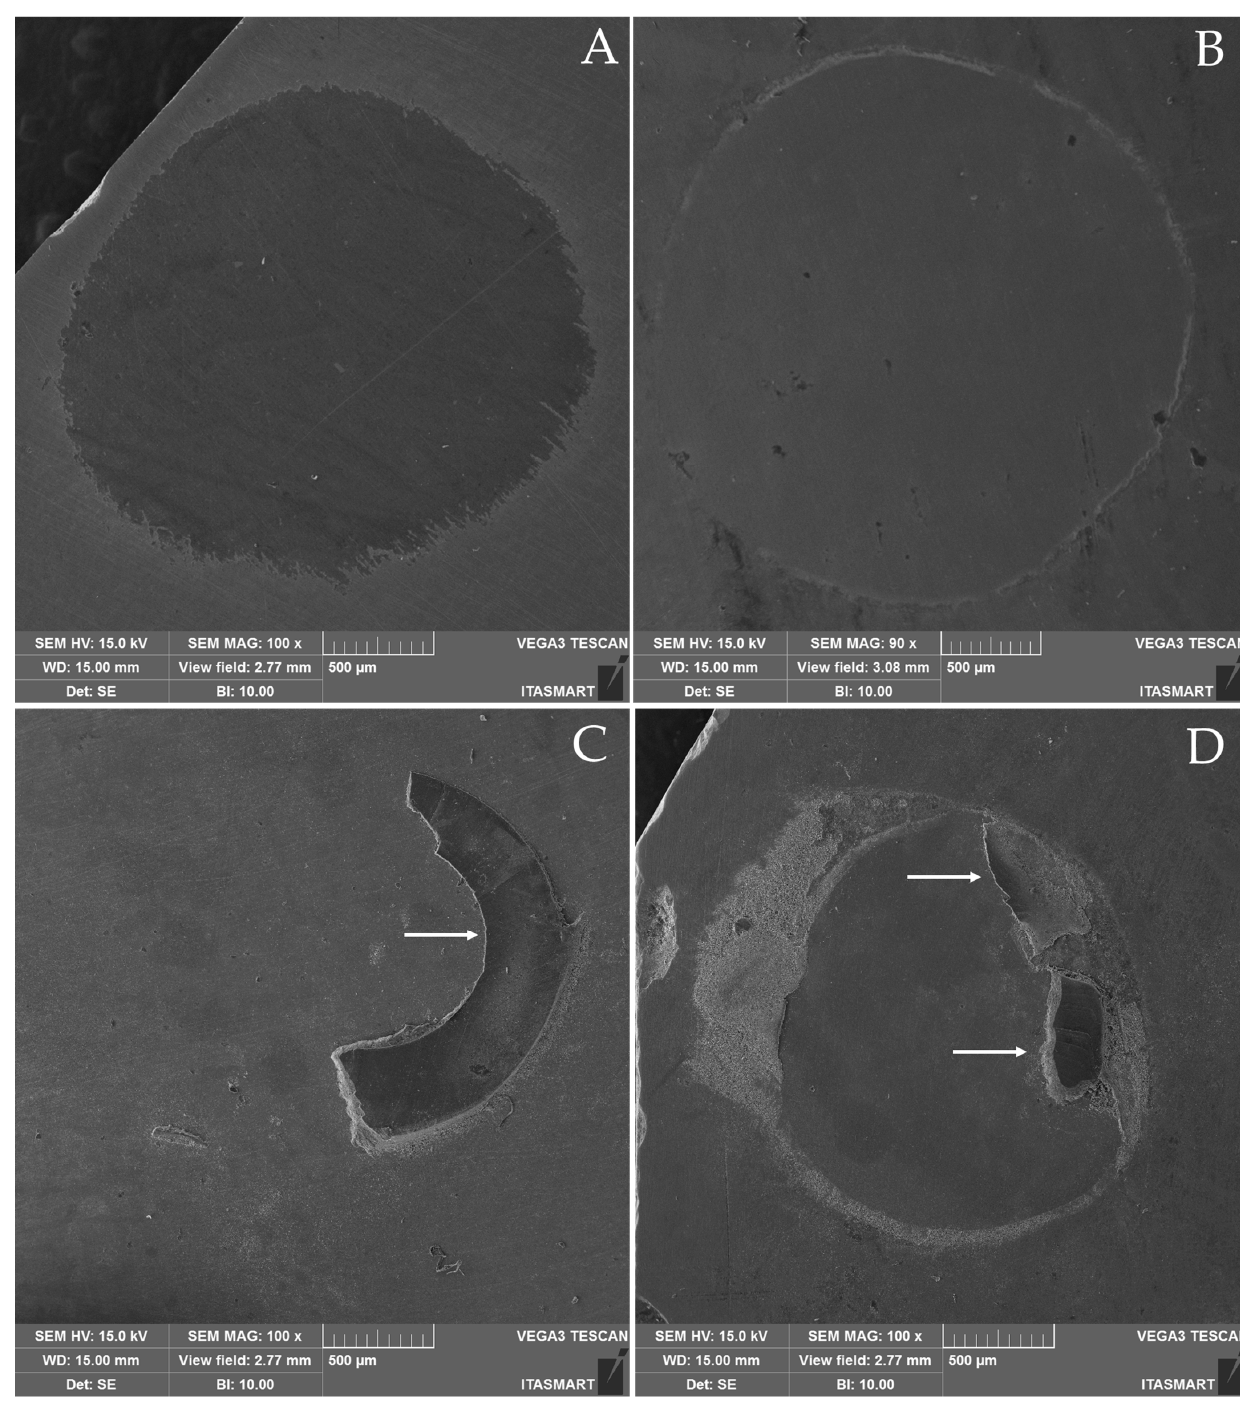
Figure 3. Representative SEM images of failure types. ( A , B ) Examples of adhesive failures on speed ‐ sintered 3Y ‐ TZP third generation and 5Y ‐ PSZ, respectively. ( C , D ) Examples of mixed failures, in which the arrows point to the cohesive failure fractions of resin cement in conventionally sintered 3Y ‐ TZP third generation and 4Y ‐ PSZ, respectively.